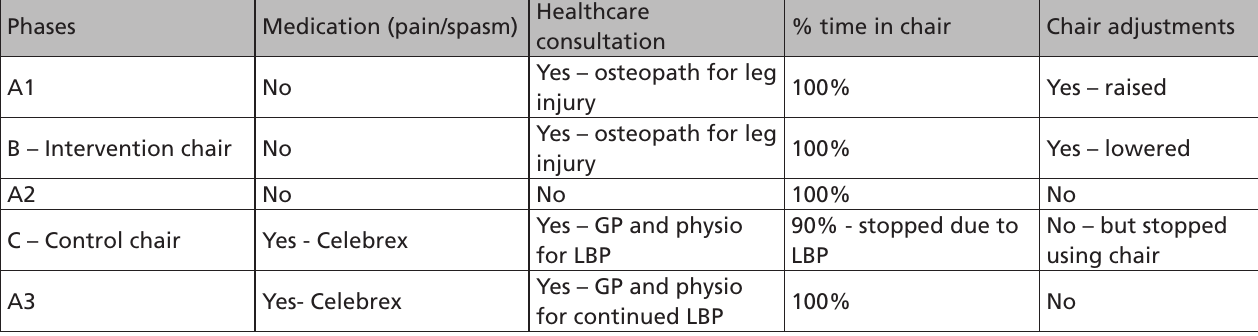
Table 5: Results of end of phase emails for Participant 2 Phases